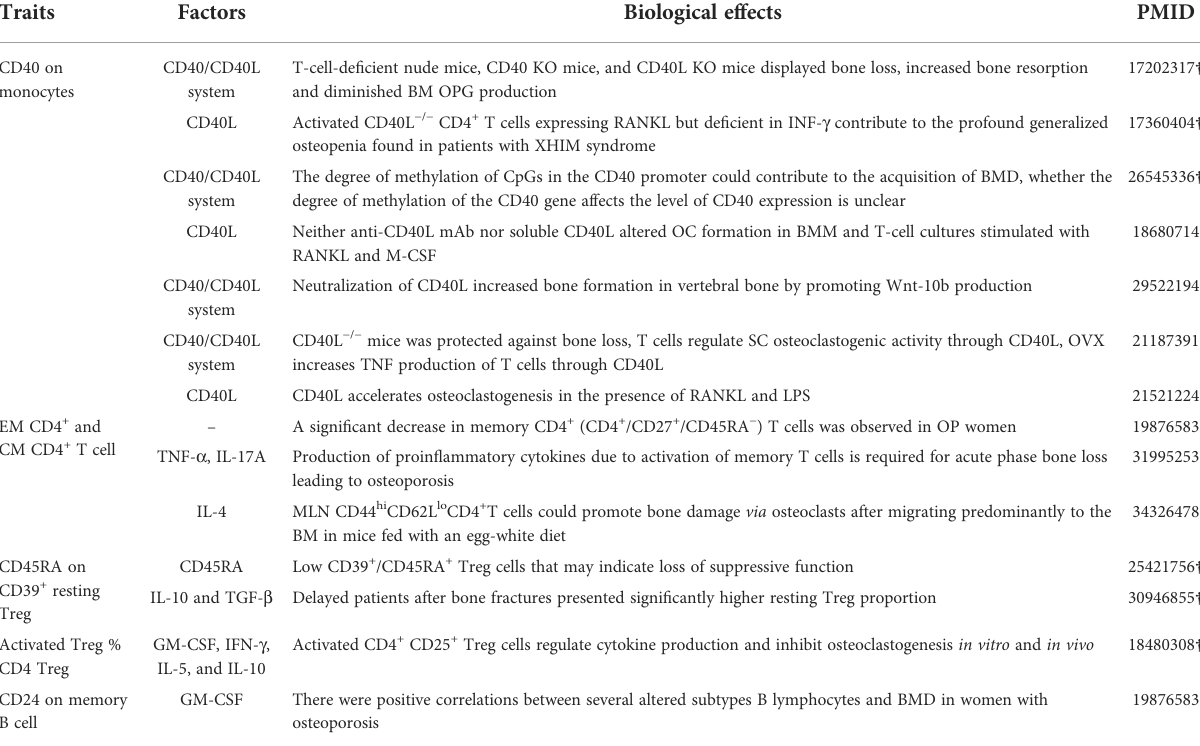
TABLE 2 The known interaction effects between immune cells and bone metabolism from previous studies.